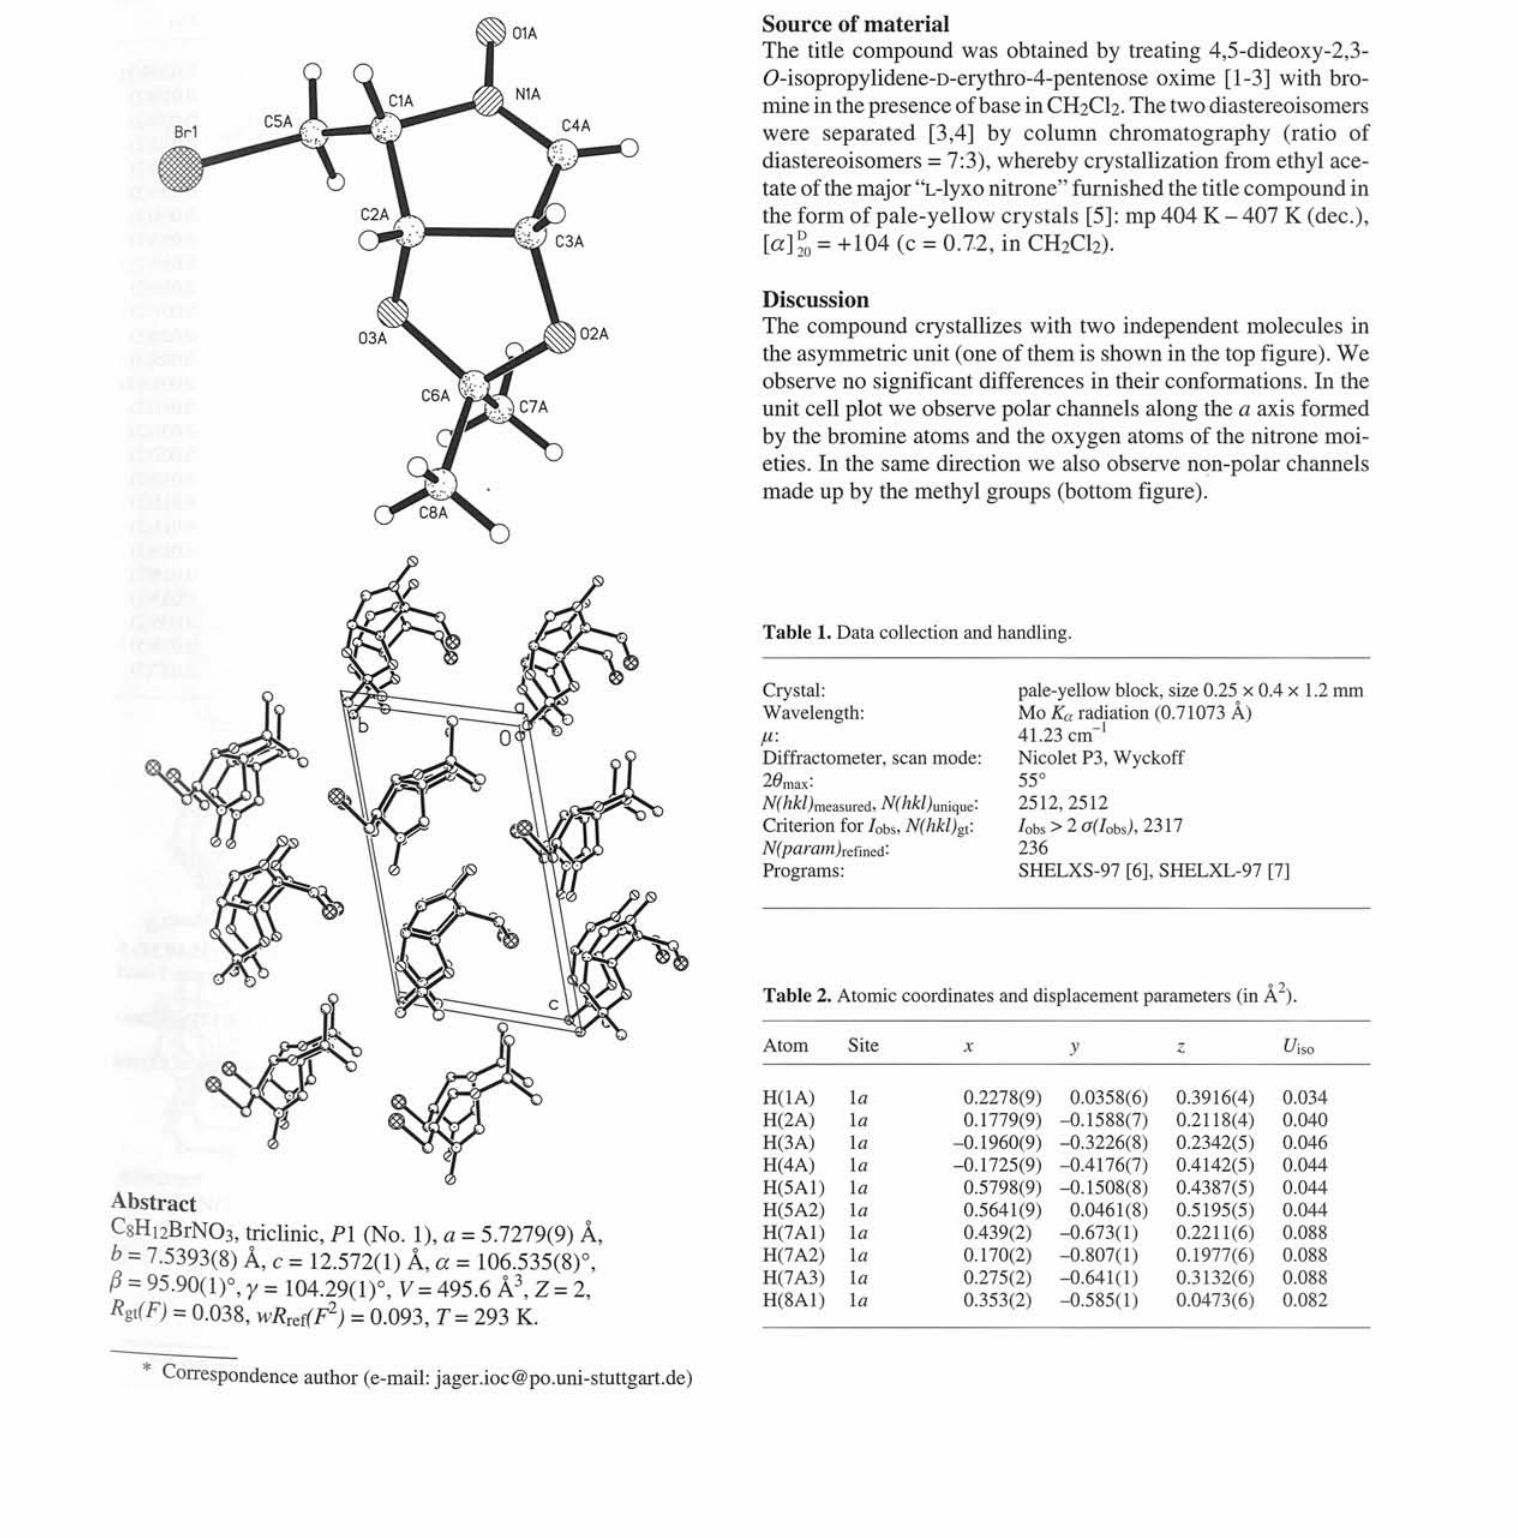
Table 2. Atomic coordinates and displacement parameters (in